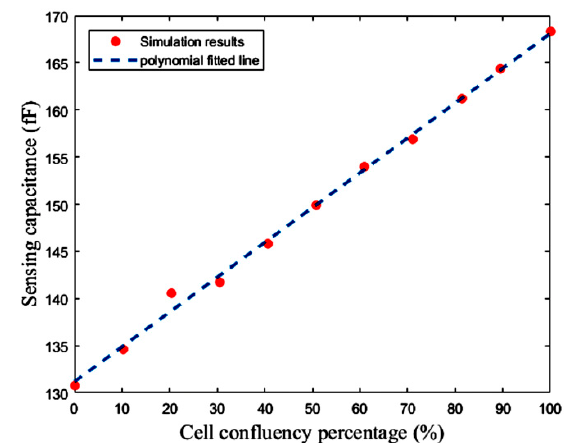
Figure 23. Sensing capacitance versus fibroblast cell confluency percentage. Table 3. Core-CBCM capacitance-to-frequency converter specifications.